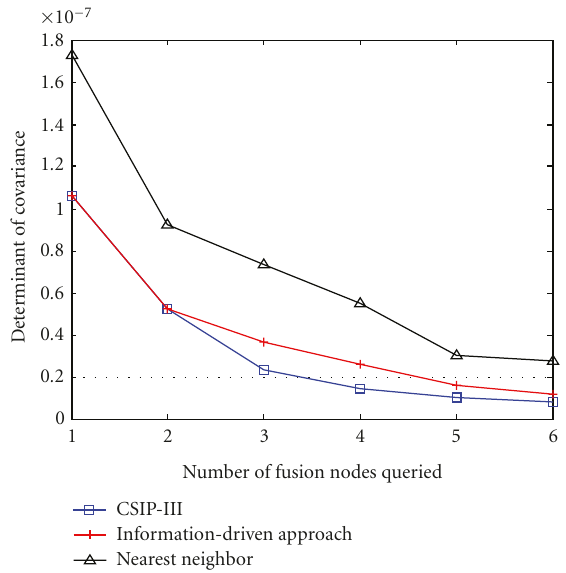
Figure 7: Determinant of the error covariance at time step t = 13 for di ff erent node selection method.